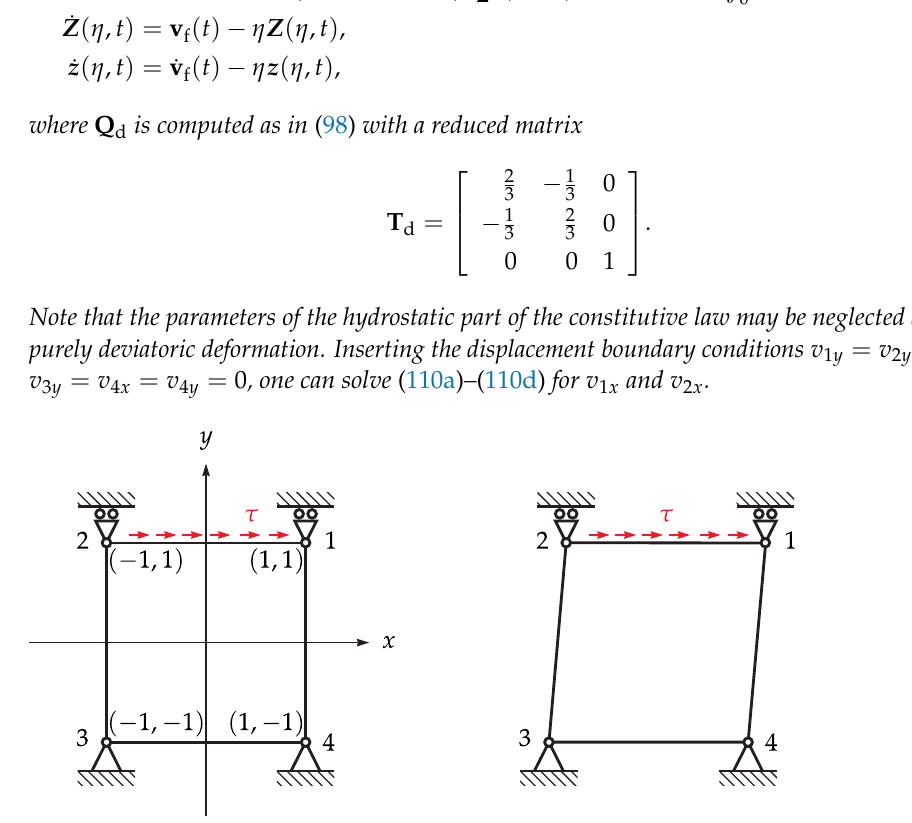
Figure 9. Fractional viscoelastic plate element in undeformed ( left ) and deformed configuration ( right ). Moreover, a closed form solution can be obtained from the spatially constant stress